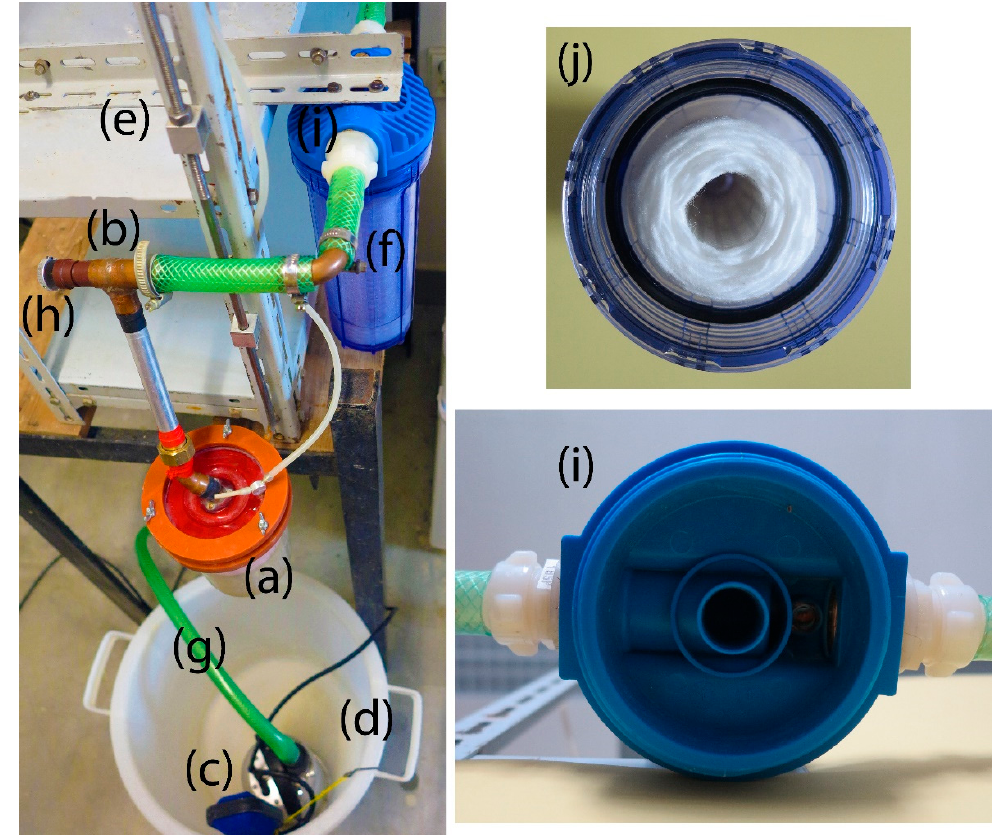
Figure 1. Test apparatus for determining erosional stability: ( a ) test cell; ( b ) flow controller; ( c ) pump; ( d ) storage/recycling vessel; ( e ) supporting structure; ( f ) filter; ( g ) supply pipe; ( h ) control button; ( i ) cap of the filter; ( j ) opened filter view.